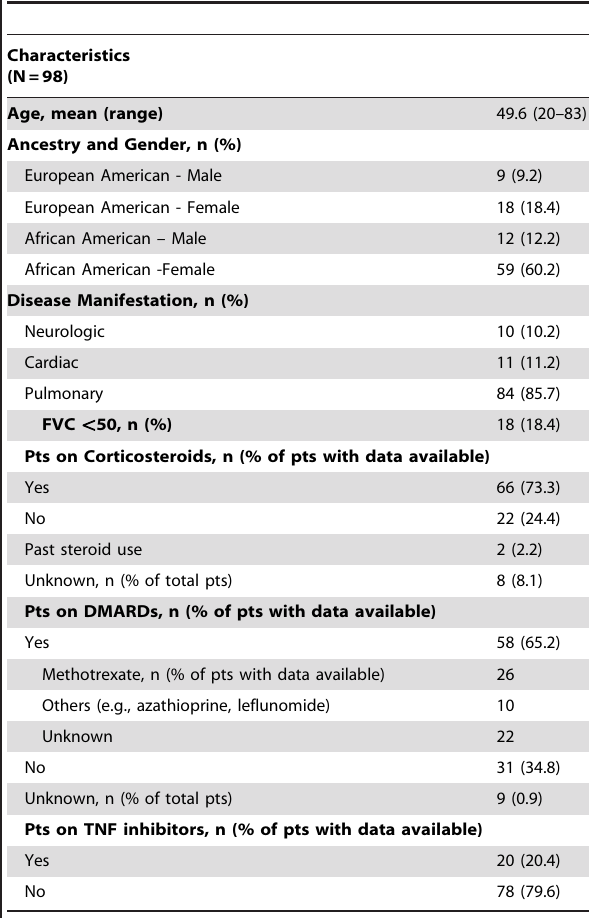
Table 1. Summary of demographic and clinical information for the sarcoidosis patients included in the